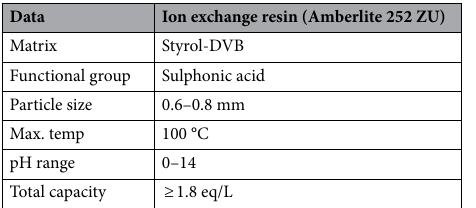
Table 1. Properties of the